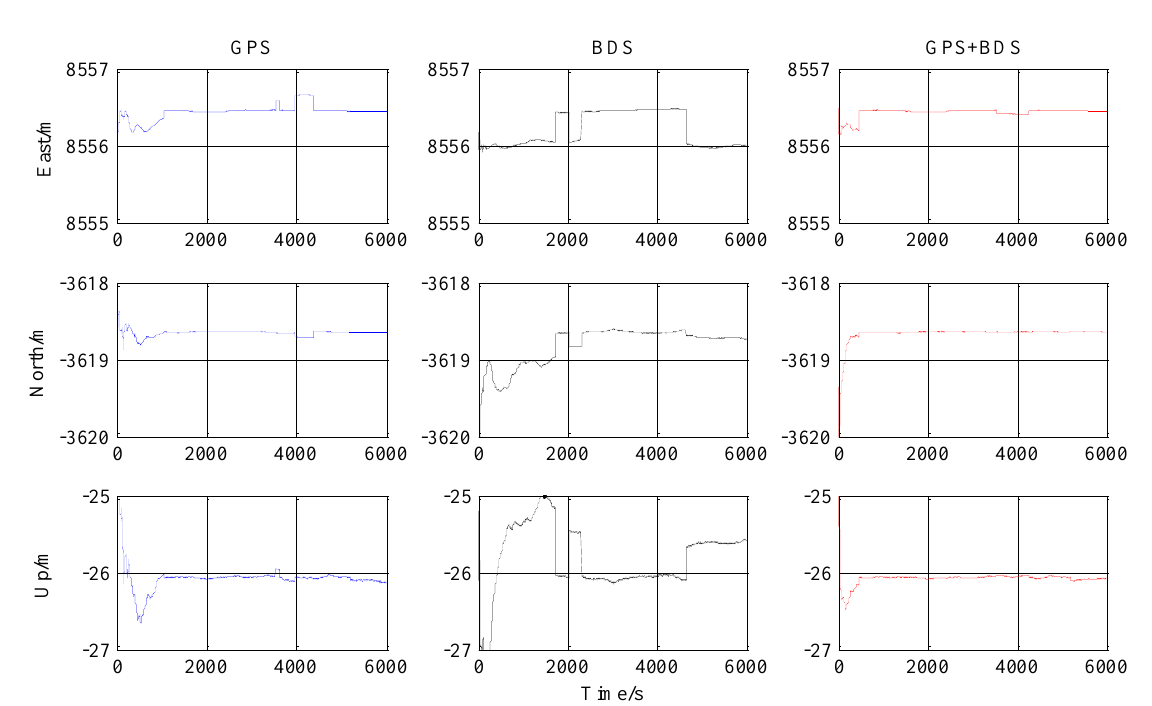
Figure 9. ENU baseline result of 9 km baseline experiment (all